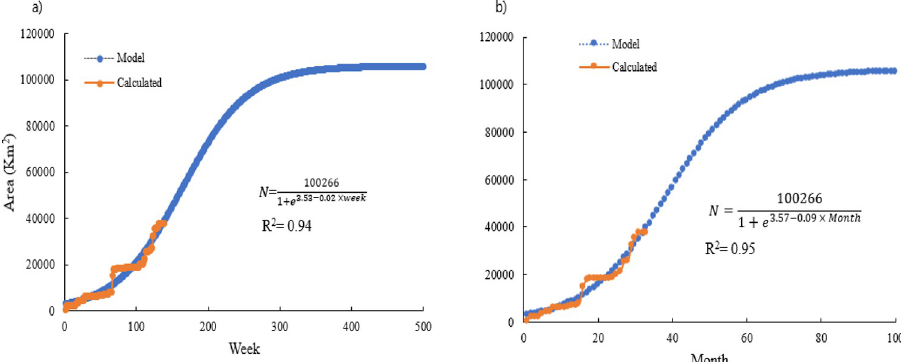
Fig 4. ASFV infection growth boundary areas and logistic fit under (a) weekly and (b) monthly